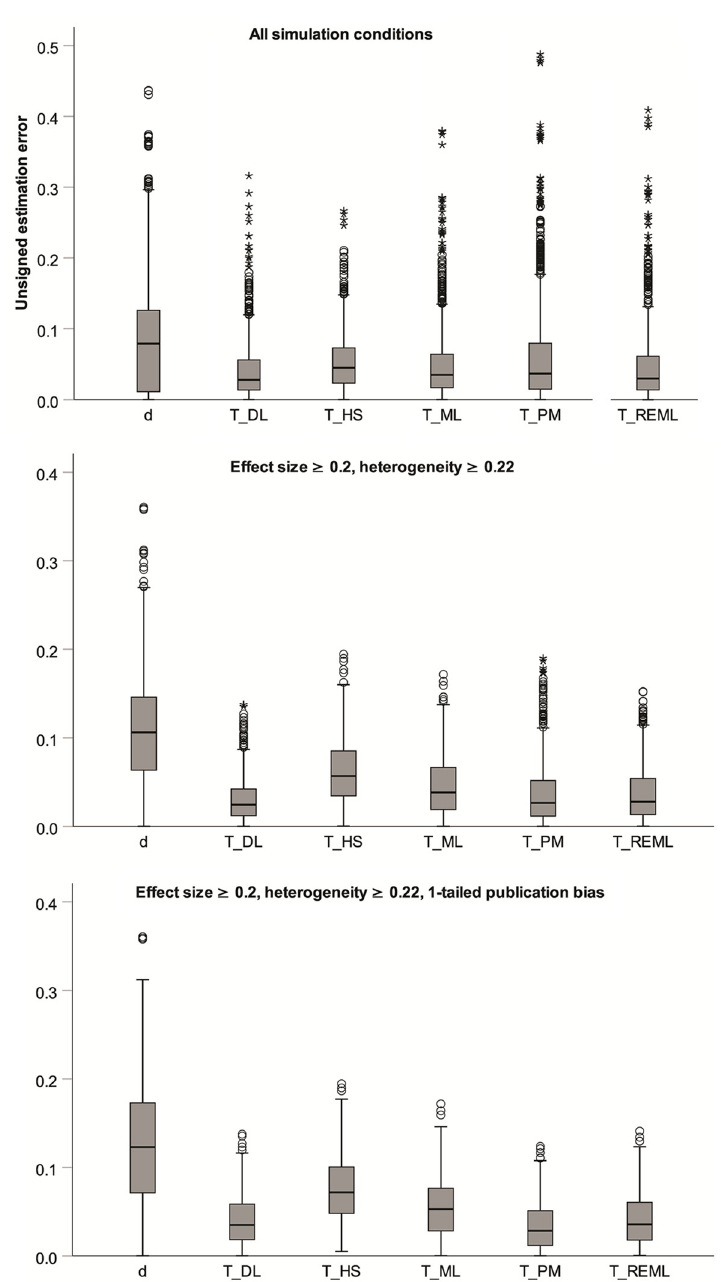
Fig 10. Comparison of errors in estimation of effect size and heterogeneity. Estimation errors for d are for the DL estimator, but virtually identical for the other estimators.